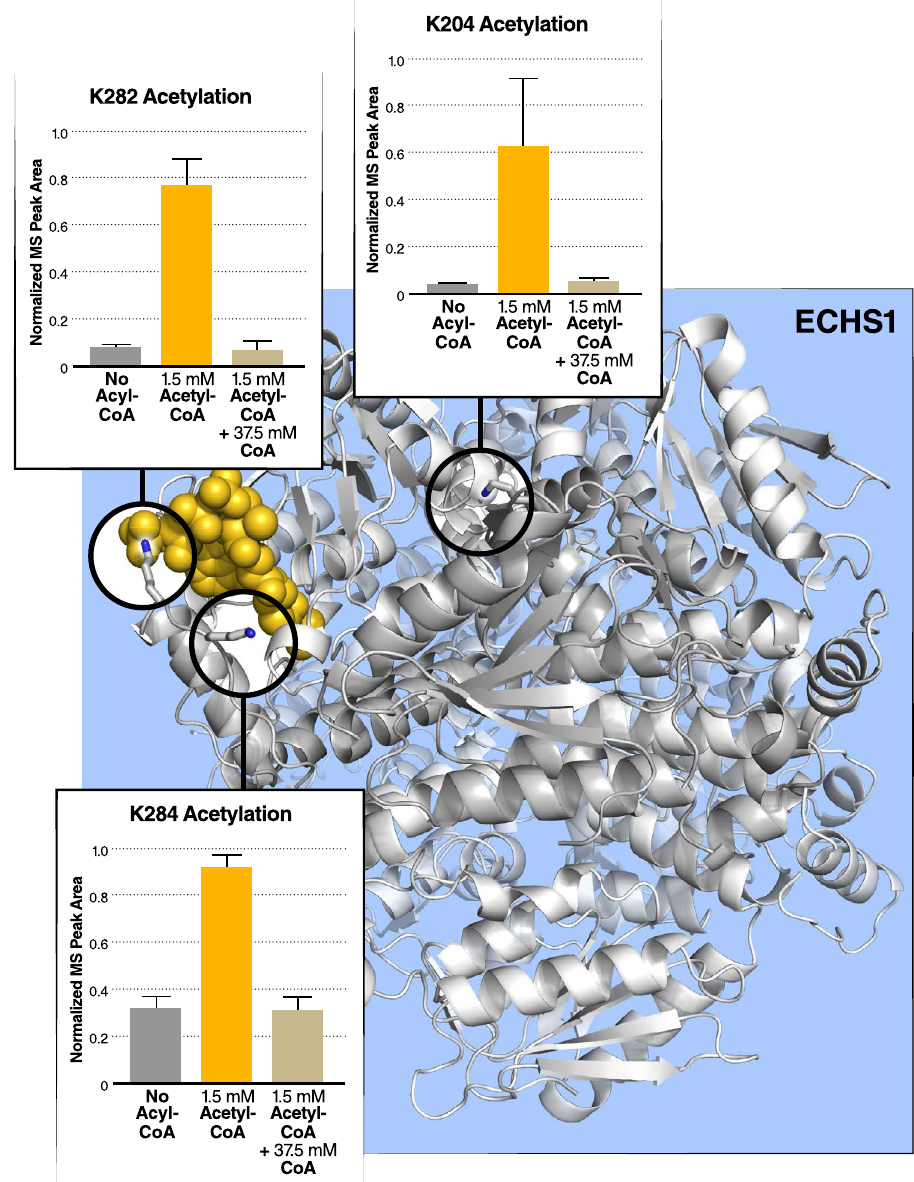
Figure 7. In-vitro acetylation of ECHS1 with acetyl-CoA is competitively inhibited by CoA at lysines proximal to the CoA-binding site. ( a ) Acetylation at three sites on bacterially produced recombinant ECHS1 increases in vitro after the addition of acetyl-CoA, and these sites are found near the CoA binding site. This acetylation via exogenous acetyl-CoA is inhibited by adding molar excess of